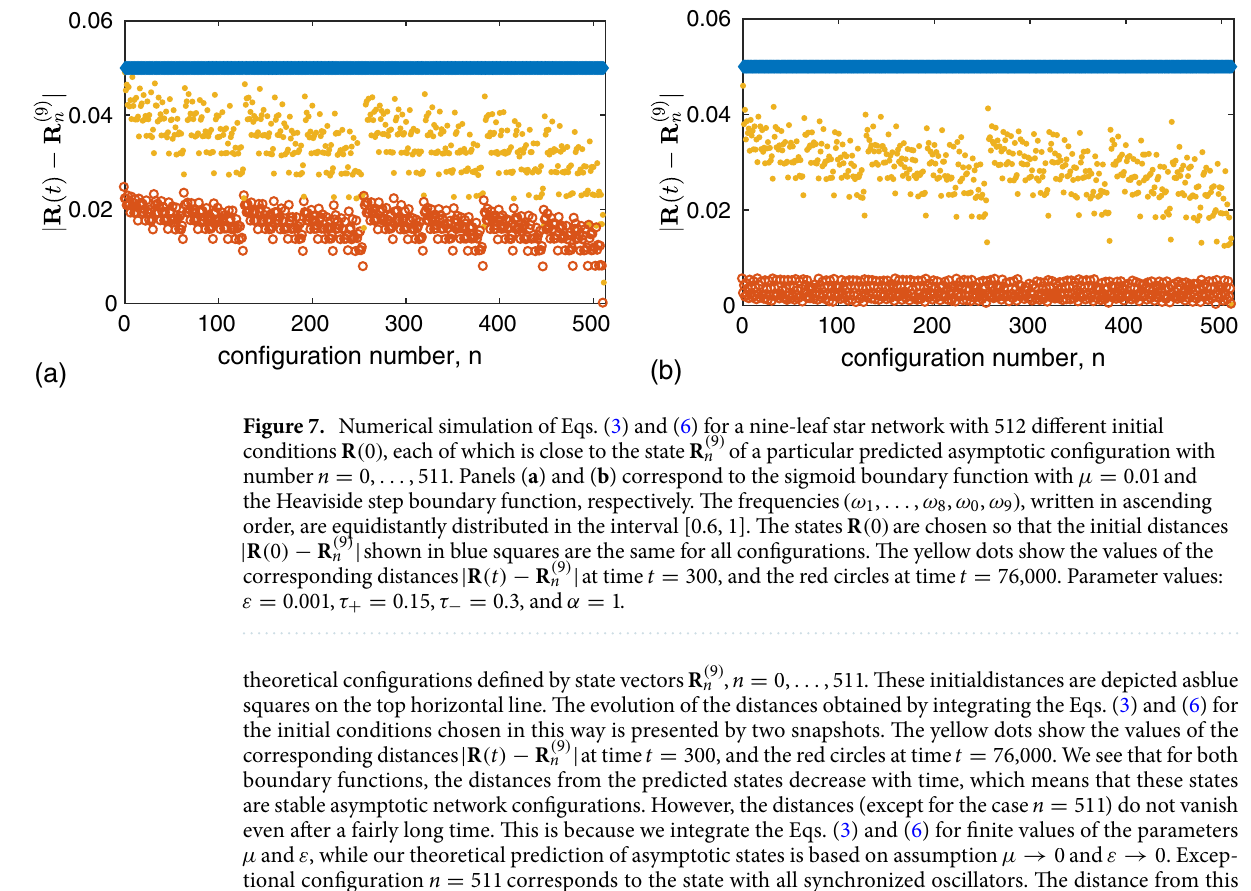
0.01 and = 76,000 . Parameter values: =